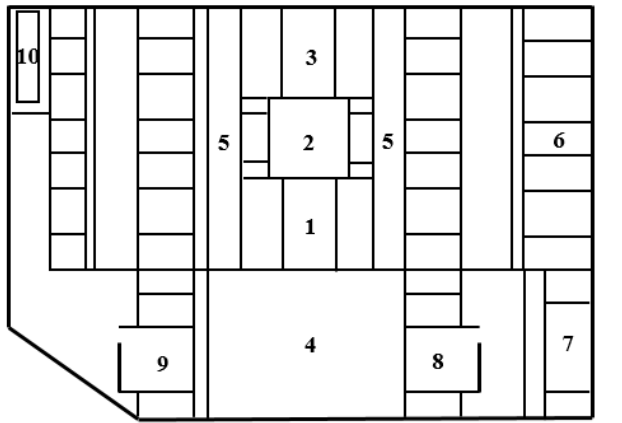
Figure 20. Floor plan of the Four Points Gold building. 1 — Front Hall; 2 — Patio; 3 — Back Hall; 4 — Qiancheng 5 — Huoxiang; 6 — Upper Book Hall; 7 — Lower Book Hall; 8 — Eastern Gate; 9 — Western Gate; 10 — Toilet.